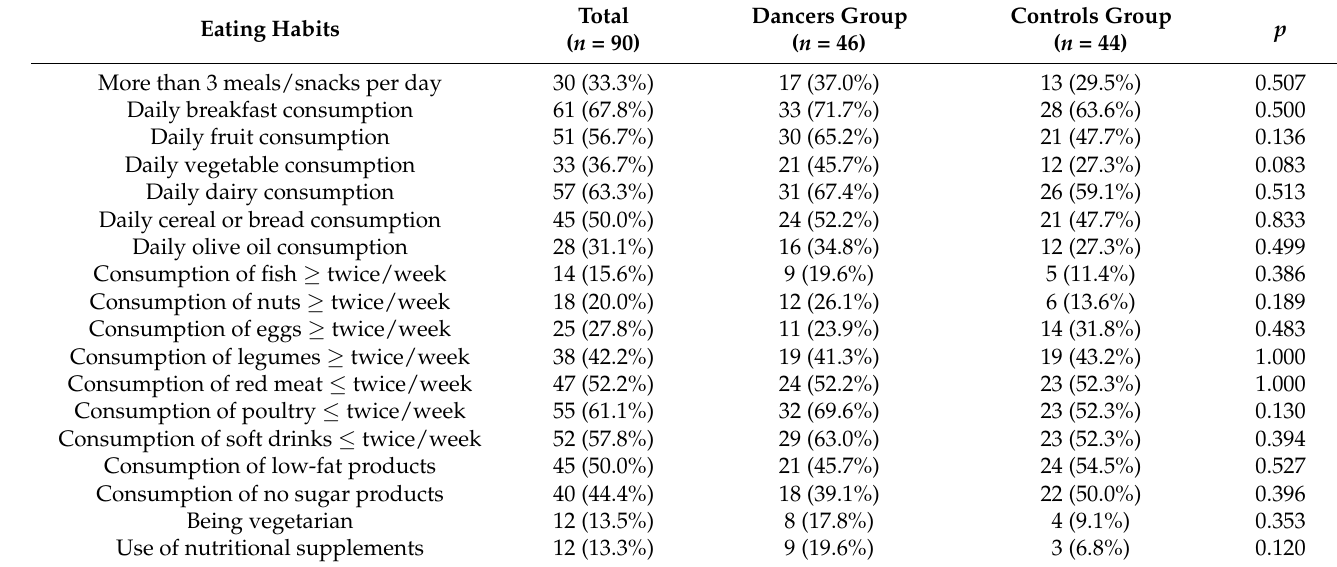
Table 2. Eating habits between adolescent dancers and non-dancers *.